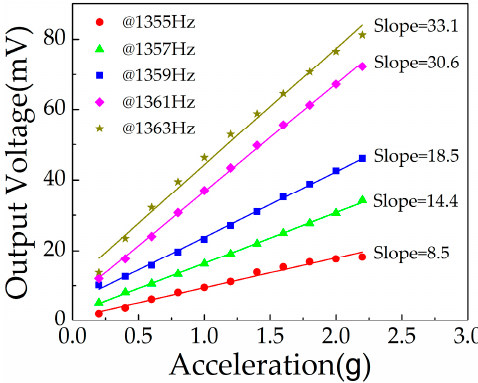
Figure 14. Output voltage of the sensor below resonance frequency.